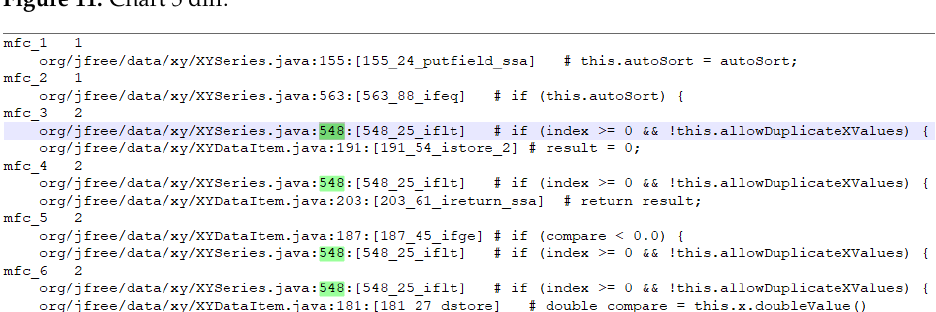
Figure 11. Chart 5 diff.